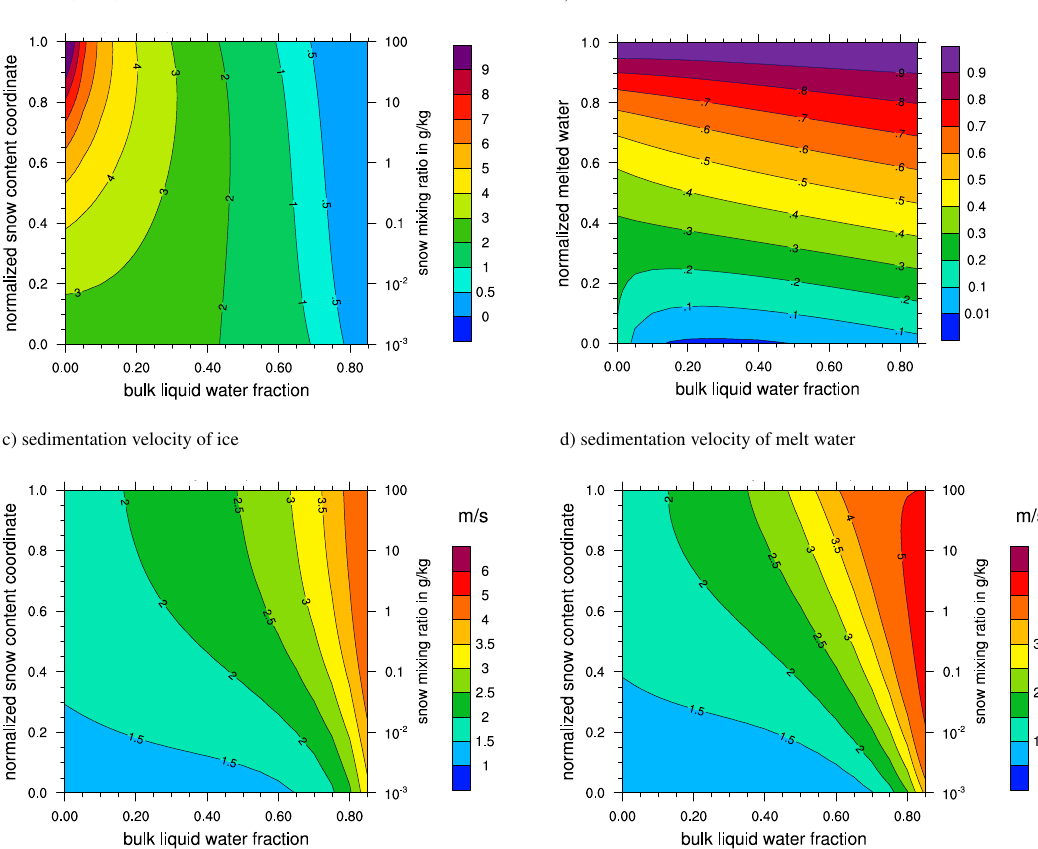
Fig. 3. Parameterizations of (a) melting, (b) conversion, and the mass-weighted sedimentation velocities of (c) ice and (d) liquid mass. Here we have assumed m s = αD 2 s with α =0 . 069 for the geometry of snow, κ =0 . 87 for the decay of the meltwater in the snow distribution, and N 0 = 8 × 10 6 m − 4 for the intercept parameter of the distribution of dry snow aloft f D = N 0 exp( − λD s ) . Shown are the analytic approximations using rational functions. The melting integral and the conversion coefficient are dimensionless quantities.